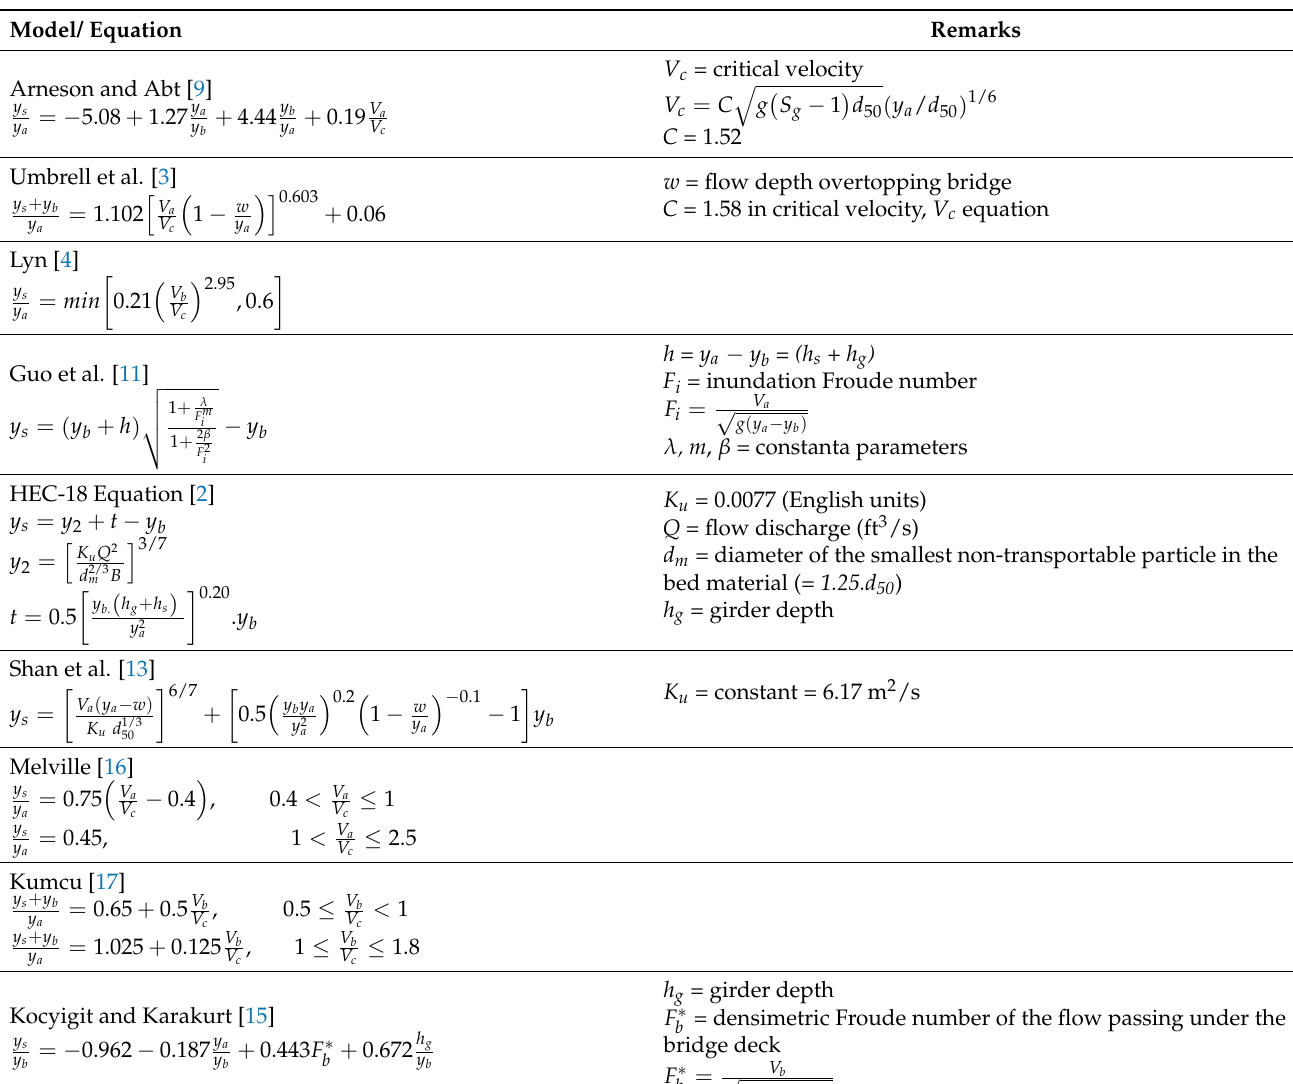
Table 1. Prediction equations for the pressure-flow scours.